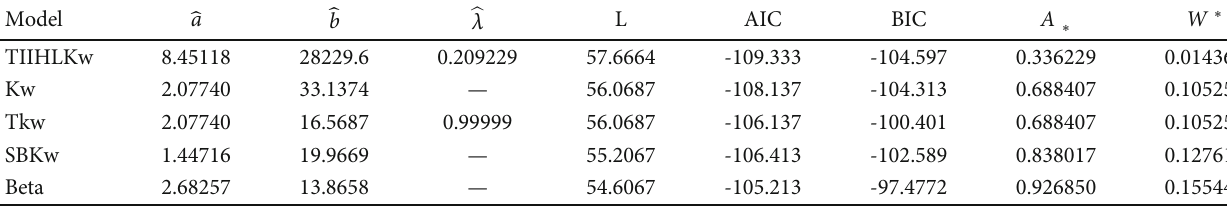
Table 7: MLEs and goodness-of- fi t measures for the fi rst data set.